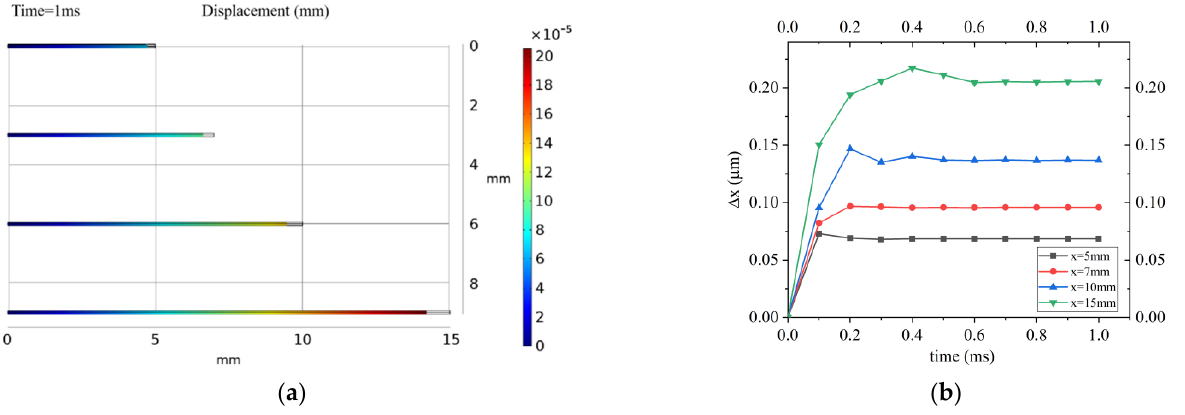
Figure 4. ( a ) Deformation of four FBGs at 1 ms at 1 MPa. ( b ) Deformation and time response of four FBGs at 1 MPa.